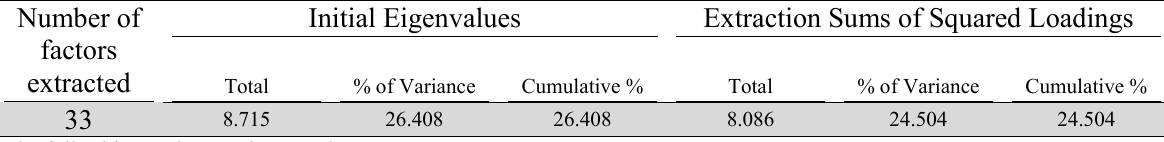
Table 3 Total Variance Explainedª Number of factors extracted